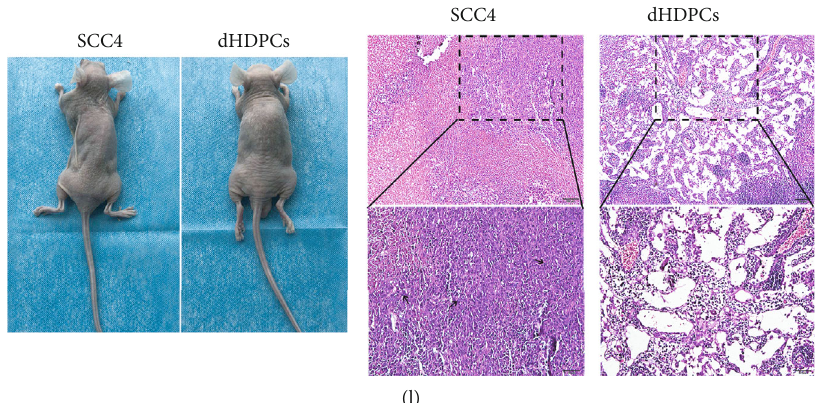
Figure 5: Deimmortalized human dental pulp cells. (a) IHDPCs transduced e ffi ciently by Ad-FLP to establish deimmortalized human dental pulp cells (dHDPCs). (b) mRNA expression of SV40T-Ag was downregulated after deimmortalization ( ∗∗∗ P < 0 : 001 ). (c) Expression of SV40T-Ag in dHDPCs. (d) The viability of dHDPCs was tested by the colony formation assay. (e) Cell proliferation assessed by the CCK8 assay ( ∗ P < 0 : 05 , ∗∗ P < 0 : 01 , and ∗∗∗ P < 0 : 001 ). (f) Cell proliferation assessed by the crystal violet staining assay. (g) The stained cells were dissolved for quantitative determination at A570nm ( ∗ P < 0 : 05 , ∗∗ P < 0 : 01 ). (h and i) Flow cytometric analysis showed the cycle distribution of HDPCs, iHDPCs, and dHDPCs ( ∗ P < 0 : 05 , ∗∗ P < 0 : 01 , and ∗∗∗ P < 0 : 001 ). (j and k) Flow cytometric analysis showed the apoptosis of HDPCs and iHDPCs ( ∗∗∗ P < 0 : 001 ). (l) The nude mouse tumorigenicity assay was used to test the oncogenicity of dHDPCs in comparison with SCC-4 cells as the positive control. There were no developed tumors in the dHDPC group after three weeks. In contrast, there were many abnormal mitotic images in the SCC-4 group